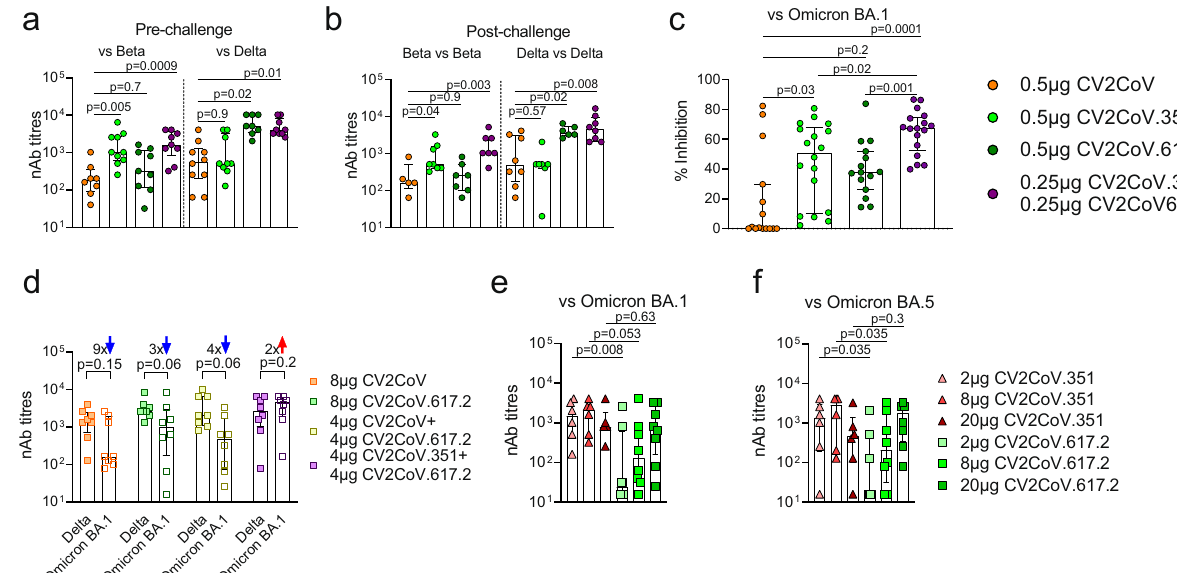
Fig. 2 | Bivalent SARS-CoV-2 mRNA vaccines induce abundant virus neutraliz- ing titres. a – c Mice were vaccinated as described in Fig. S2, 0.5 µ g CV2CoV (ancestral, orange), 0.5 µ g CV2CoV.351 (Beta, light green), 0.5 µ g CV2CoV.617.2 (Delta,darkgreen),orCV2CoV.351+CV2CoV.617.2(0.25 µ gofeach;purple).Animal numbersanalysed aresummarizedintableS1.Neutralizingantibody(nAb)titresat Day 56 (Pre-challenge) ( a ), Day 66 (Post-challenge) ( b ), and surrogate virus- neutralization titres (sVNT) (% inhibition) at Day 56 (Pre-challenge) ( c ). Each dot represents an individual animal. Scatter plots are labelled with median and inter- quartile range. p- values were determined by one-way ANOVA and Dunn ’ s multiple comparisontestagainstCV2CoV(orange)( a – c ). d – f Wistarratswerevaccinatedon Day 0 and 21 as described in Fig. S4, 8 µ g CV2CoV (ancestral, light orange), 8 µ g CV2CoV.617.2 (Delta, light green), CV2CoV+CV2CoV.617.2 (4 µ g of each; light